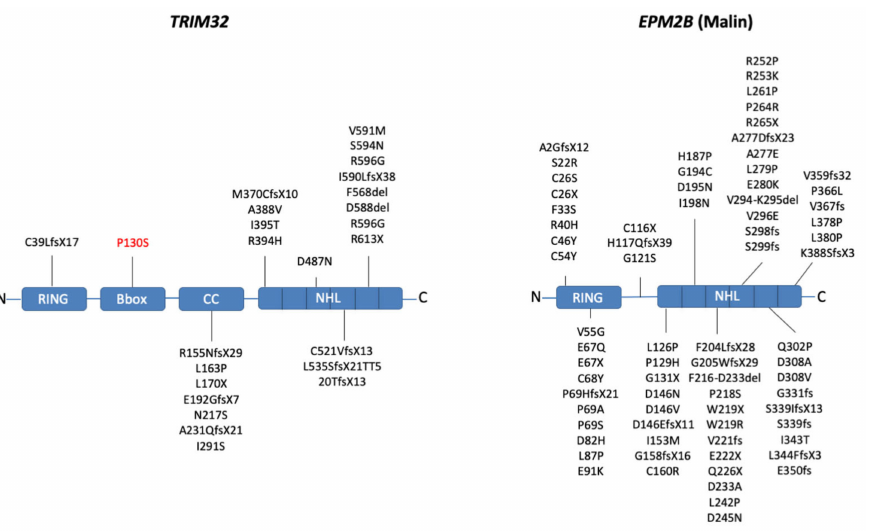
Figure 4. Graphical summary of the pathological mutations occurring in TRIM32 (left) and EPM2B (malin; right) genes. Domain names are indicated and the mutations within the NHL domains are grouped according to single NHL repeats. Most LGMDR8-causing mutations cluster within the C-terminal NHL domain of TRIM32 and may be in common with the allelic disease sarcotubular myopathy (STM), while the P130S mutation in the B-box (red) is associated with BBS11. LD-causing mutations in EPM2B are more homogeneously